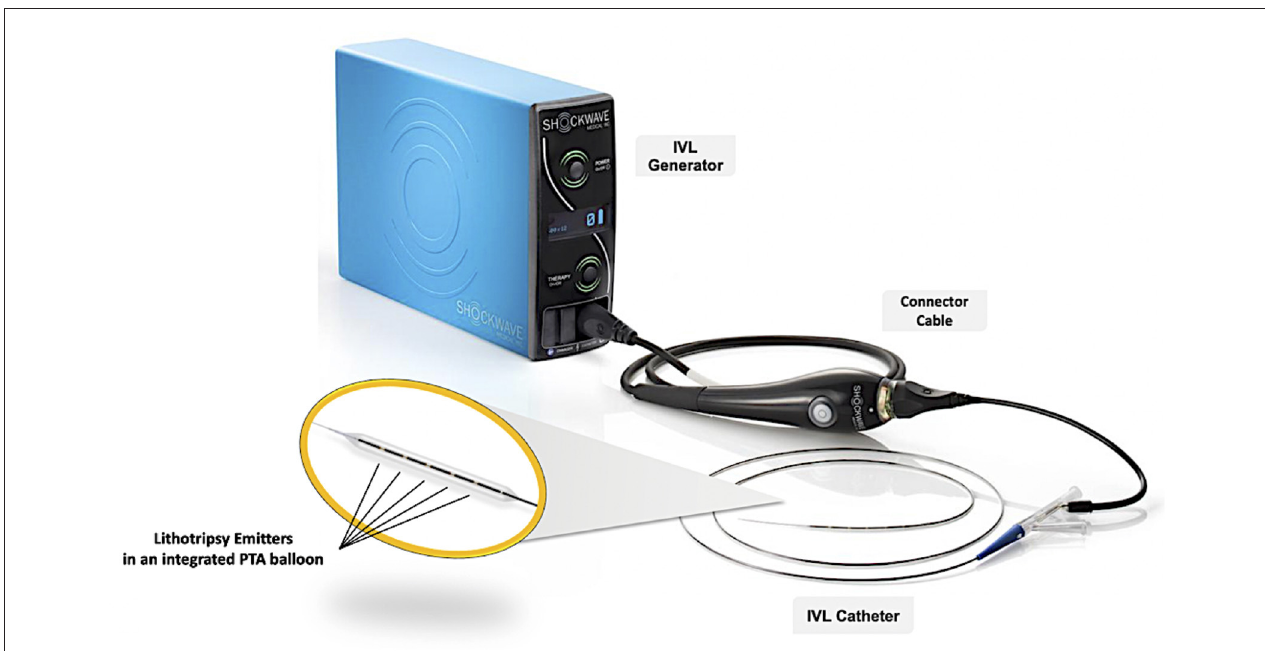
FIGURE 3 | Shockwave IVL system components. The Shockwave IVL system consists of three components: (1) a portable IVL generator, (2) a connector cable with magnetic connection and push-button activation, and (3) an IVL catheter that houses an array of lithotripsy emitters enclosed in an integrated PTA balloon. IVL, intravascular lithotripsy; PTA, percutaneous transluminal